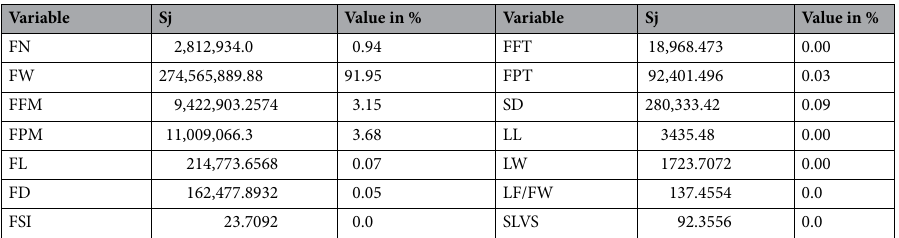
Table 2. Relative contribution of 14 quantitative morphoagronomic descriptors of Psidium guajava for genetic divergence by the Singh method. UENF, municipality of Campos dos Goytacazes, 2022. FN fruit number, FW fruit weight, FFM fruit flesh mass, FPM fruit placental mass, FL fruit length, FD fruit diameter, FSI fruit shape index, FFT fruit flesh thickness, FPT fruit placental thickness, SD stem diameter at 10 cm from the soil, LF leaf length, LW leaf width, LF/WR leaf length/width ratio, SLVS secondary leaf vein